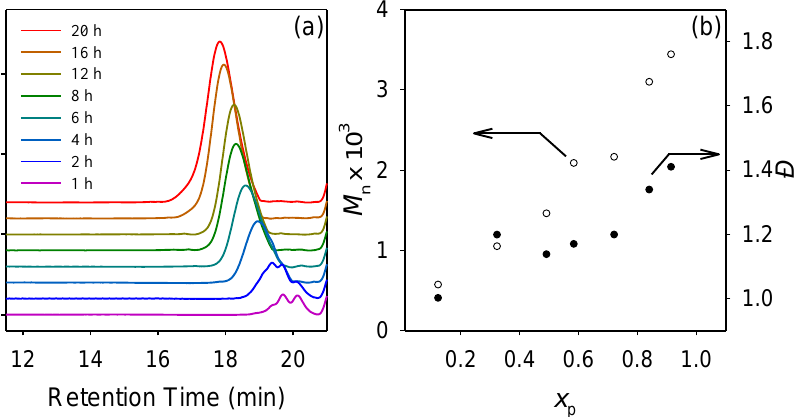
Figure 5. ( a ) GPC curves of PCL and ( b ) plots of M n and Ð versus monomer conversion ( x p ) collected at different intervals. Conditions: DMC-EAA = 10 mg ([ Zn ] 0 = 30 mM), [ CL ] 0 = 9 M, [ CL ] 0 /[ GL ] 0 = 20, T p = 130 °C.